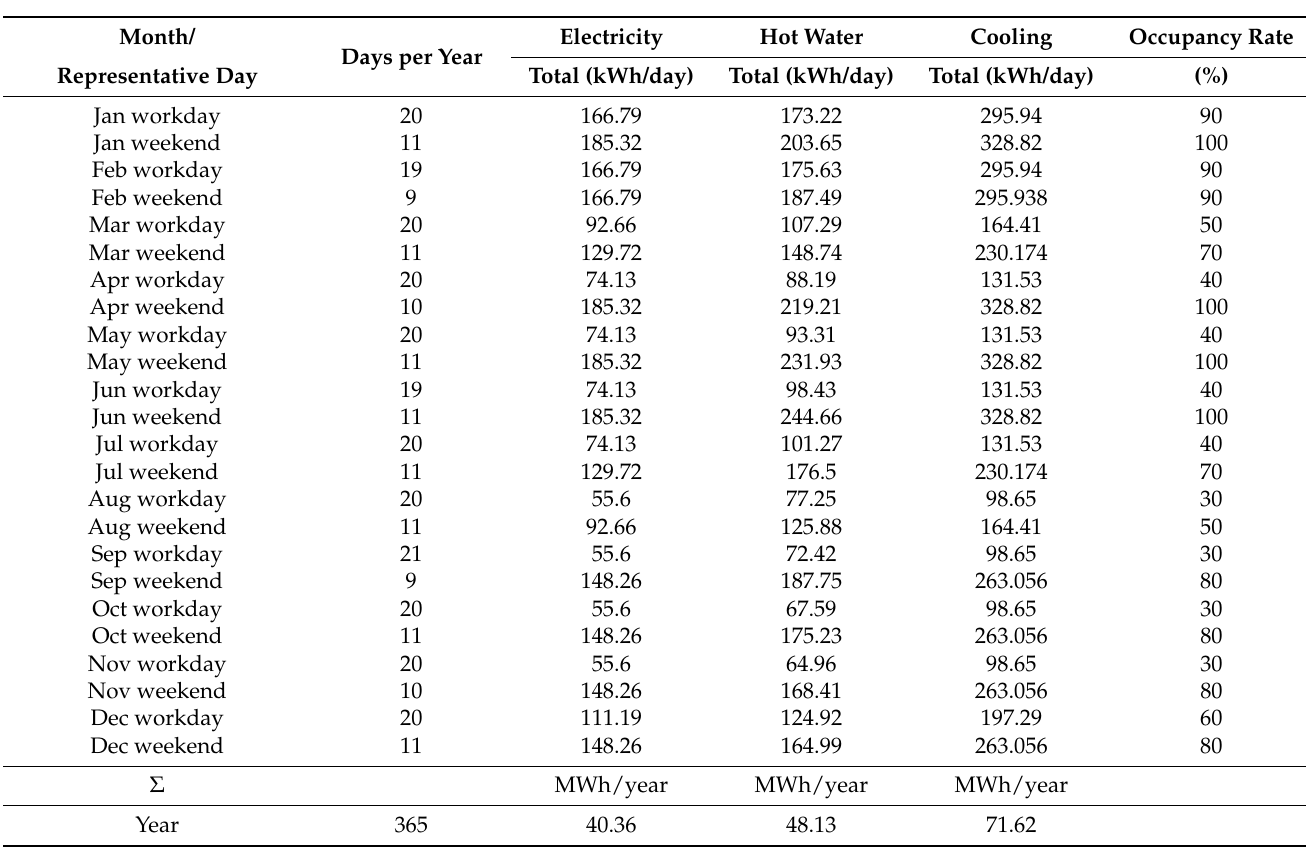
Table 1. Energy demands for the